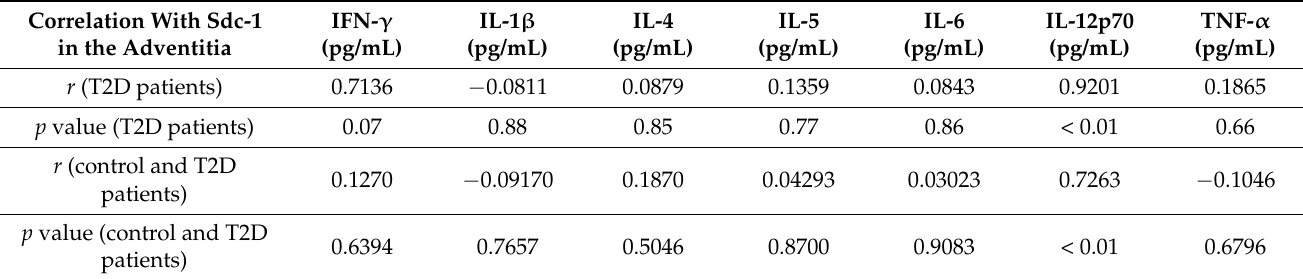
Table 2. Correlation of Sdc-1 Expression in the Adventitia and Different